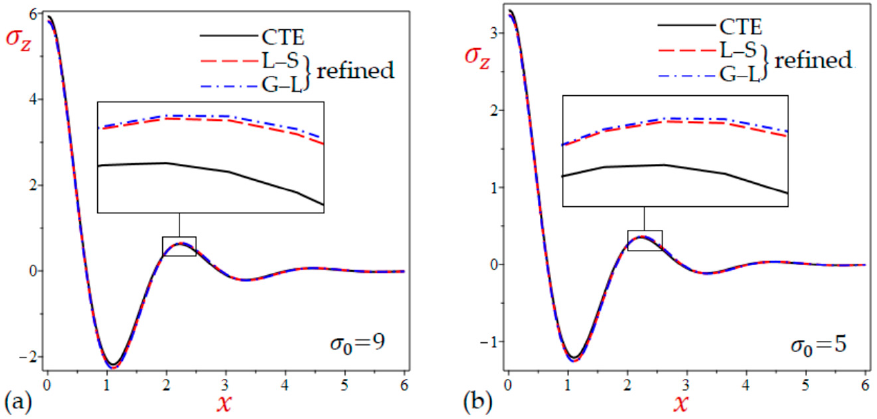
Figure 12. Effect of initial stress σ 0 on the transverse normal stress σ z of the rotating half-space